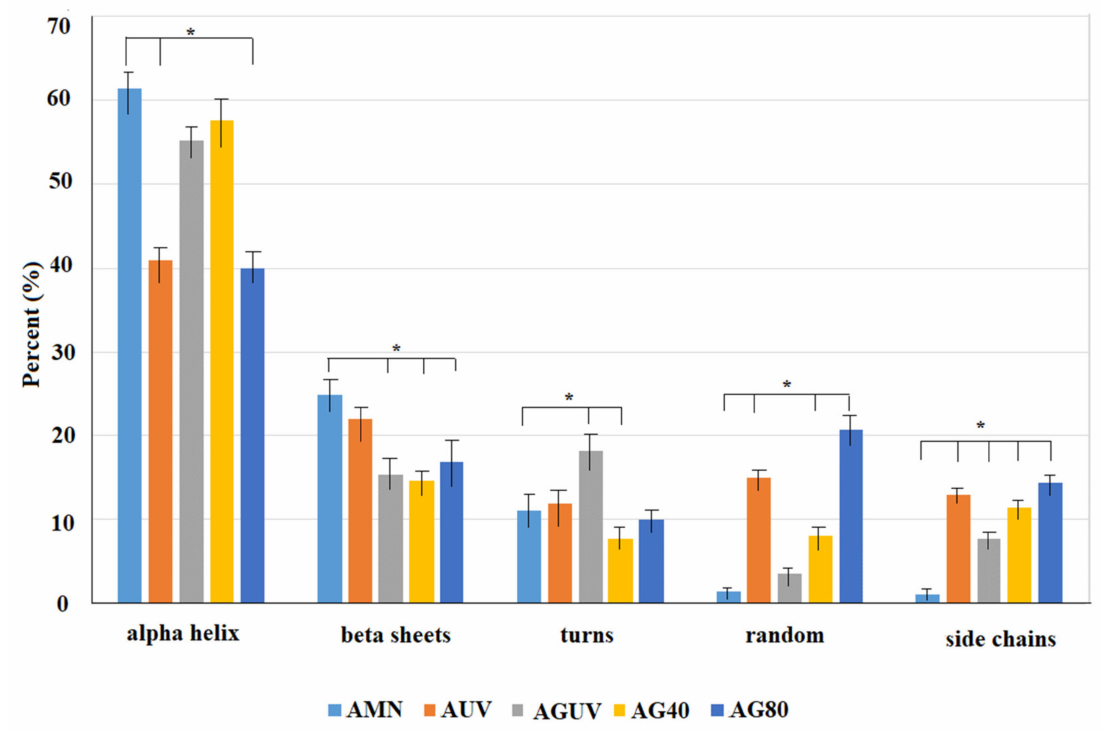
Figure 6. Quantitative analysis (percent) of the collagen secondary structure in the amniotic membrane after different treatments: natural membrane (AMN), 1 h exposure to UV (AUV), gentamicin treatment (40 mg/mL) and 1 h exposure to UV (AGUV), gentamicin treatment 40 mg/mL. * p < 0.05 was considered